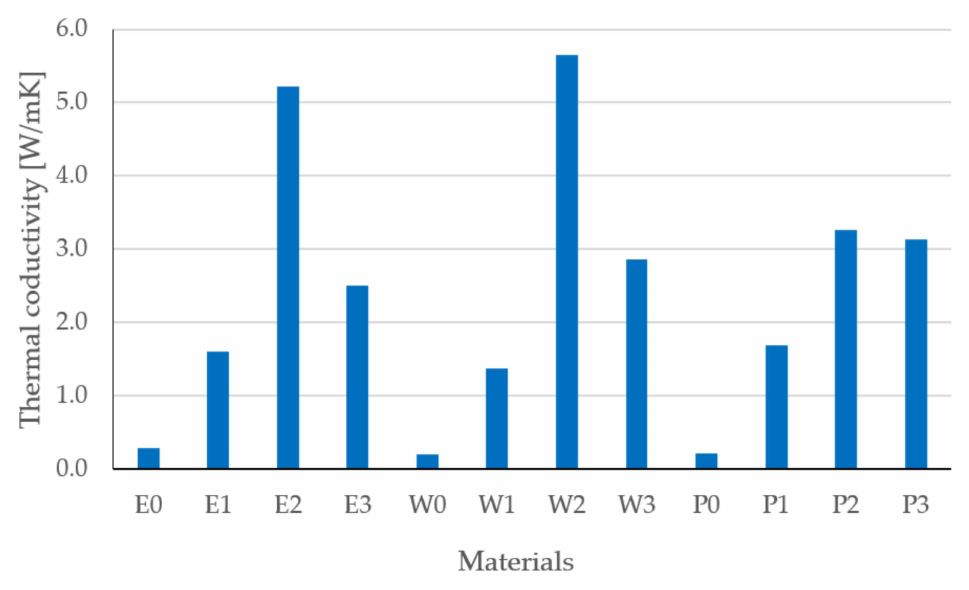
Figure 12. Results of thermal conductivity